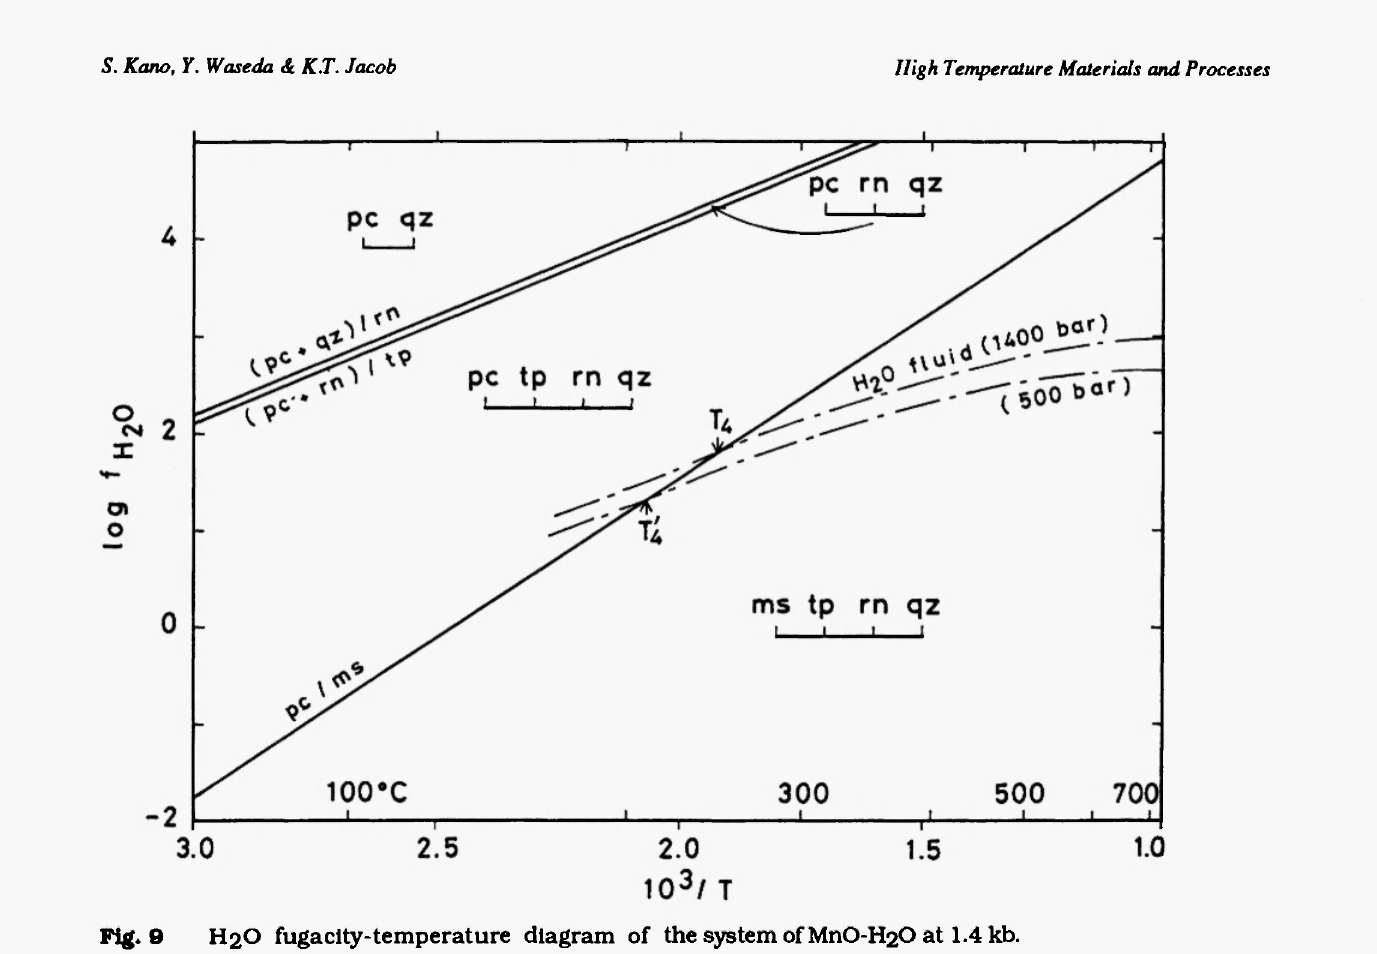
Fig. θ Η2θ fugacity-temperature diagram of the system of ΜηΟ-Η2θ at 1.4